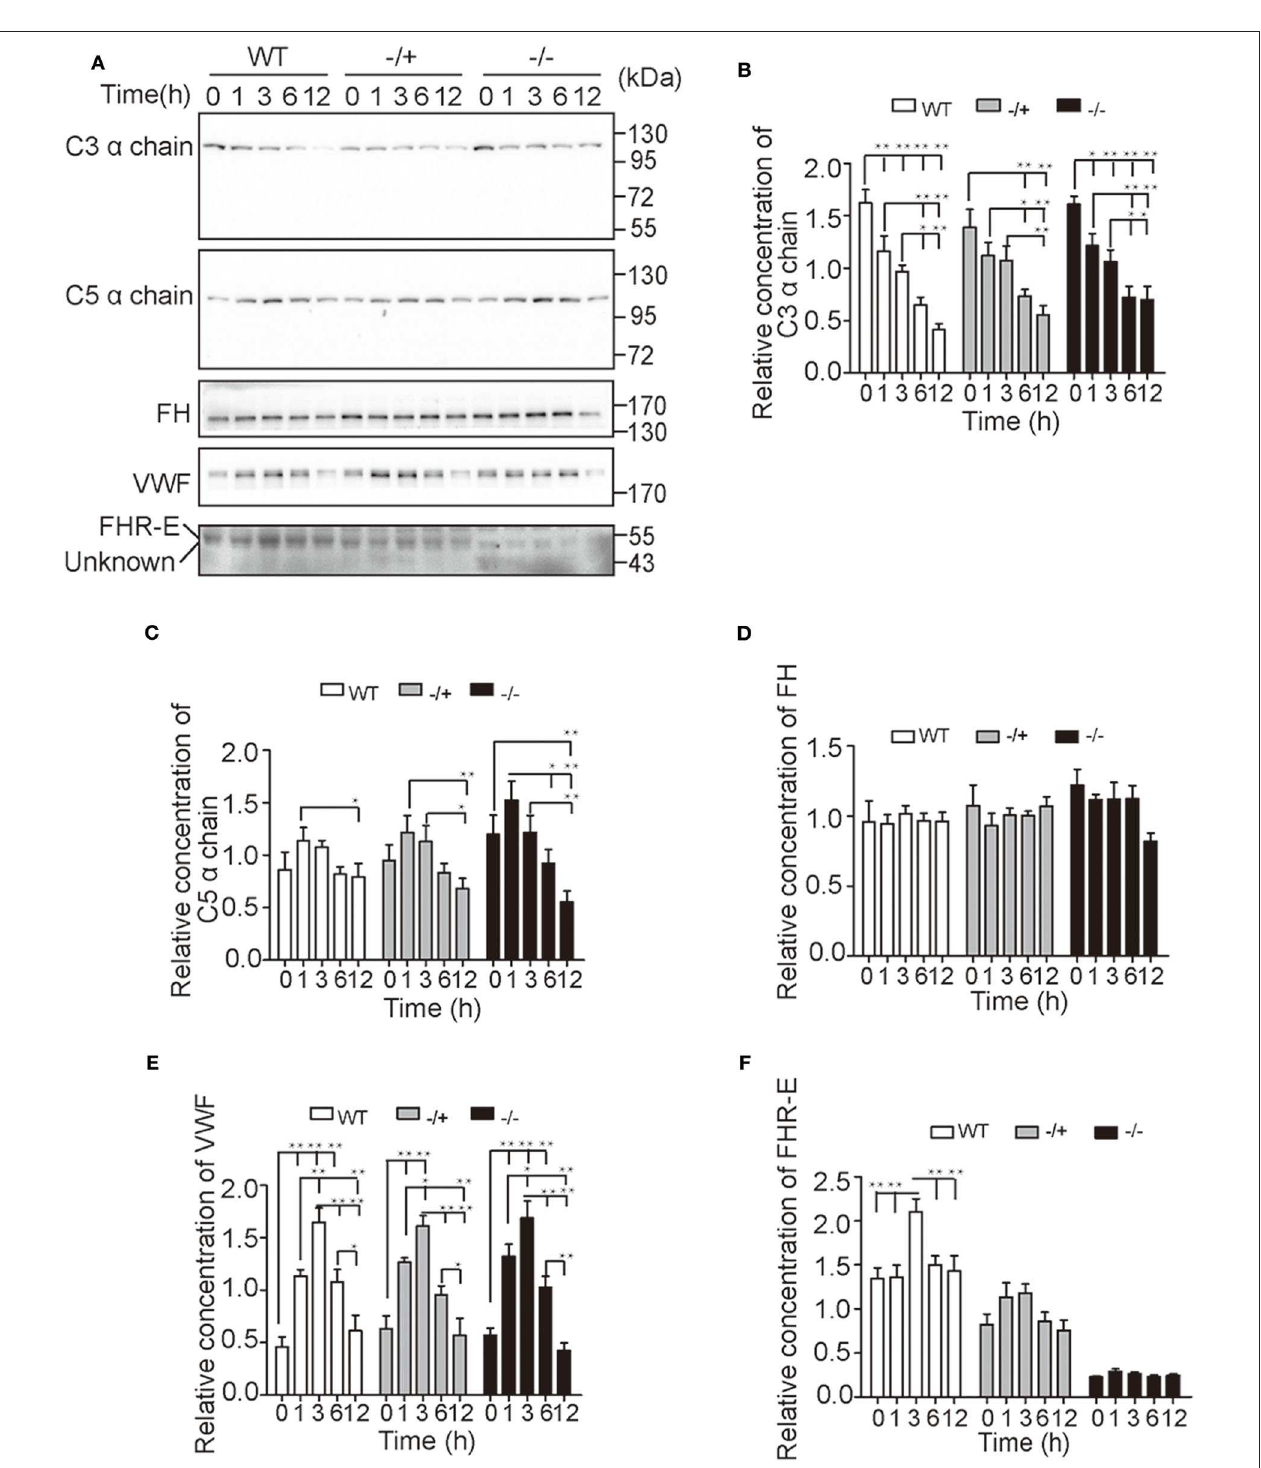
FIGURE 5 | Detection of major complement and coagulation factors after in vivo LPS challenge. (A) Time-course changes of C3, C5, FH, VWF, and FHR-E expression levels analyzed by Western blotting. Equal volume of plasma was loaded. Five mice in each group were used. “Unknown” means unknown proteins recognized by the anti-FHR-E antibody. (B–F) The gray value quantification of C3, C5, FH, VWF, and FHR-E in (A) measured with Image J. The gray values of each membrane were divided by the average gray value of all samples on the membrane. The data were analyzed with one-way ANOVA. * p < 0.05, ** p < 0.01.